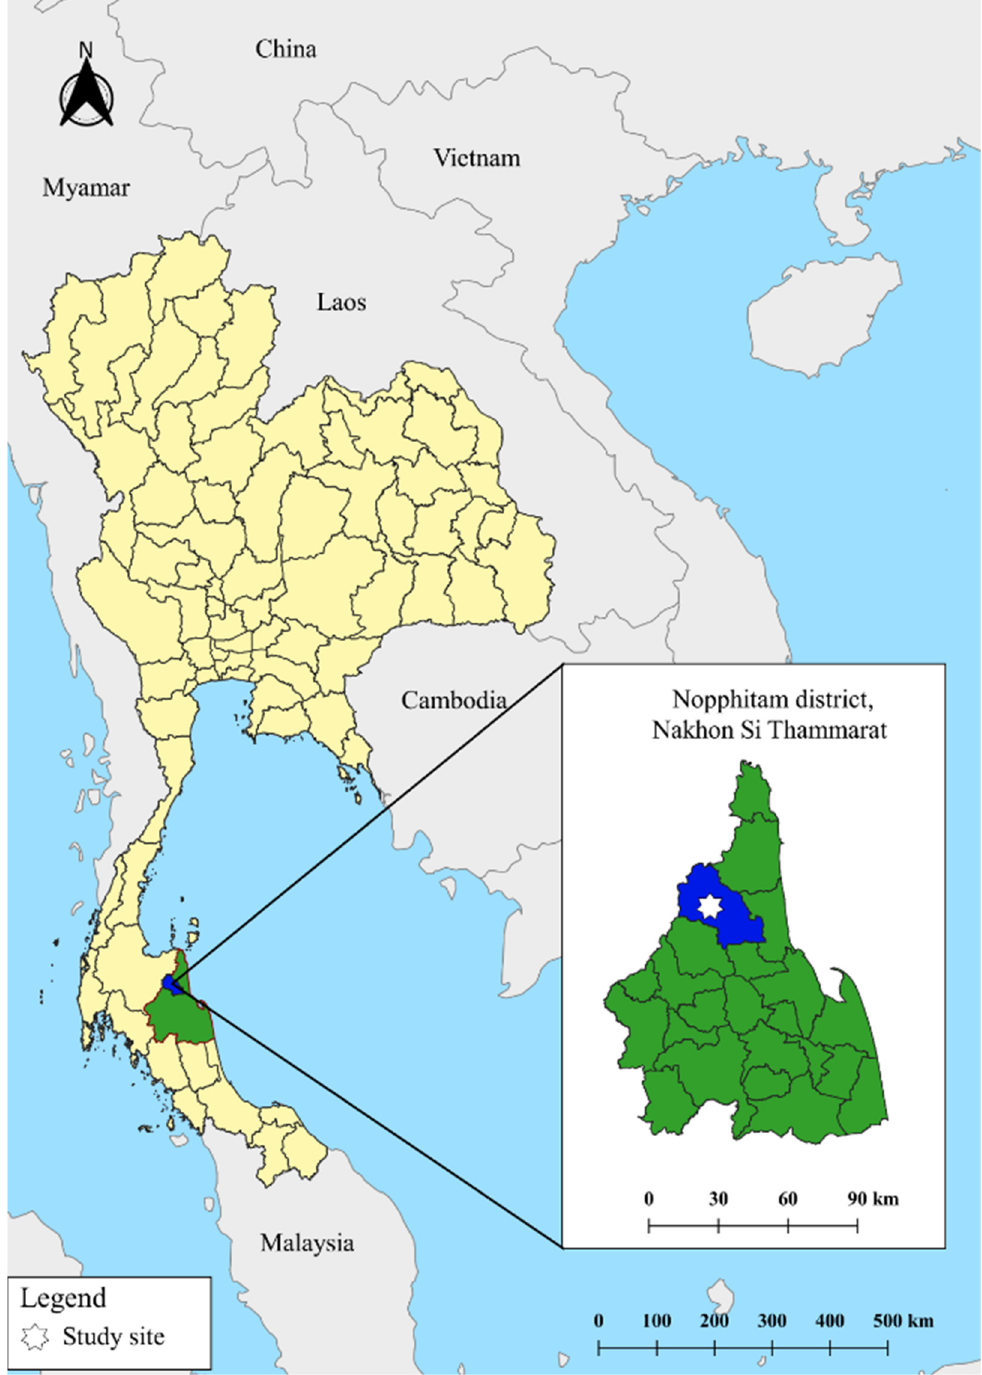
Figure 1. Location of the study site—Nopphitam District, Nakhon Si Thammarat Province, Thailand. Quantum GIS version 3.12 (ESRI base maps) was used to generate the map (https://qgis.org/en/site/ (accessed on 30 December 2021)).